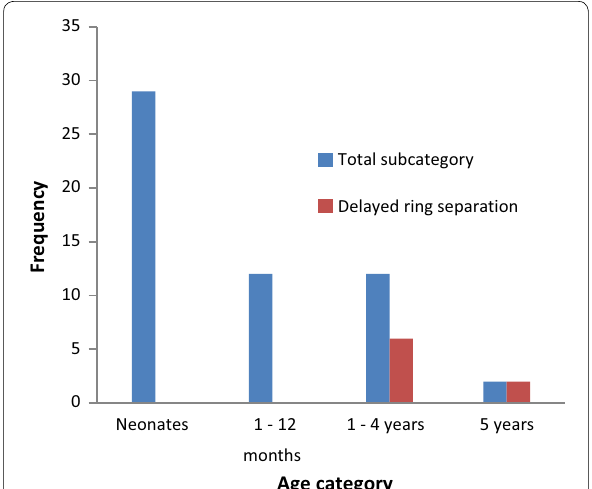
Fig. 3 Boys that had delayed separation of the Residual plastic ring following Plastibell circumcision